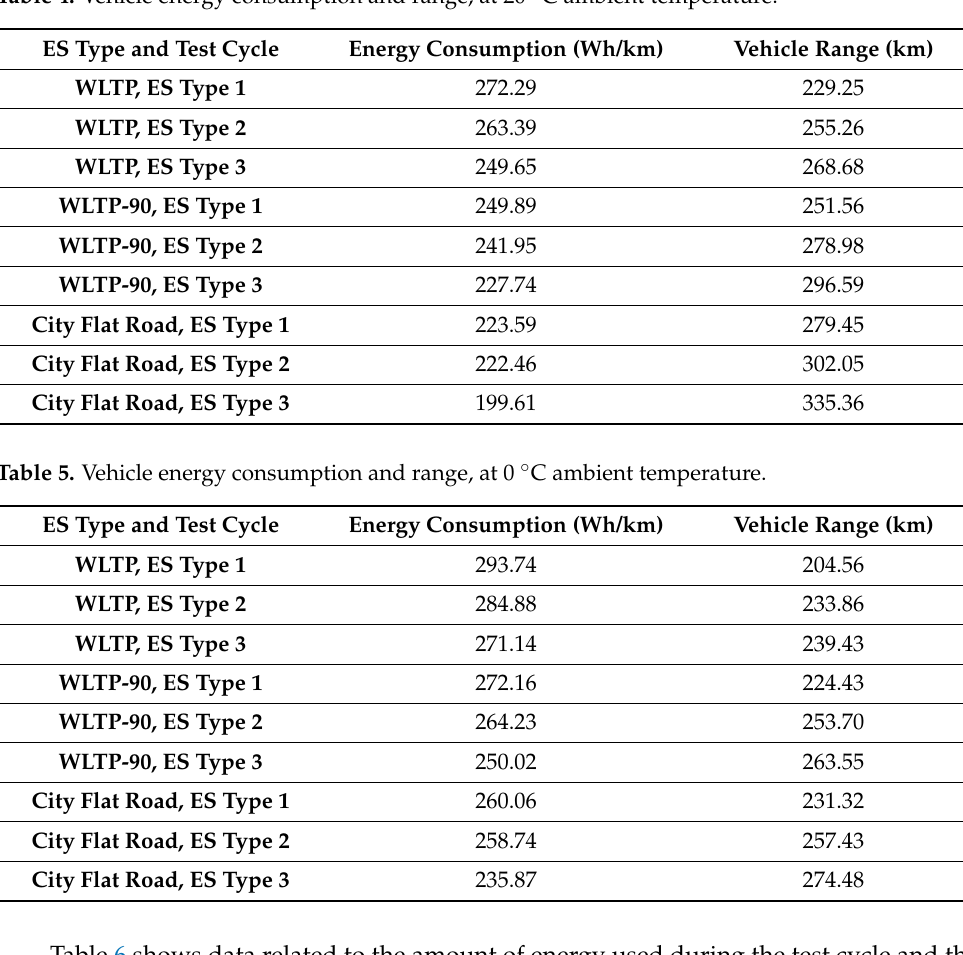
Table 4. Vehicle energy consumption and range, at 20 ◦ C ambient temperature.